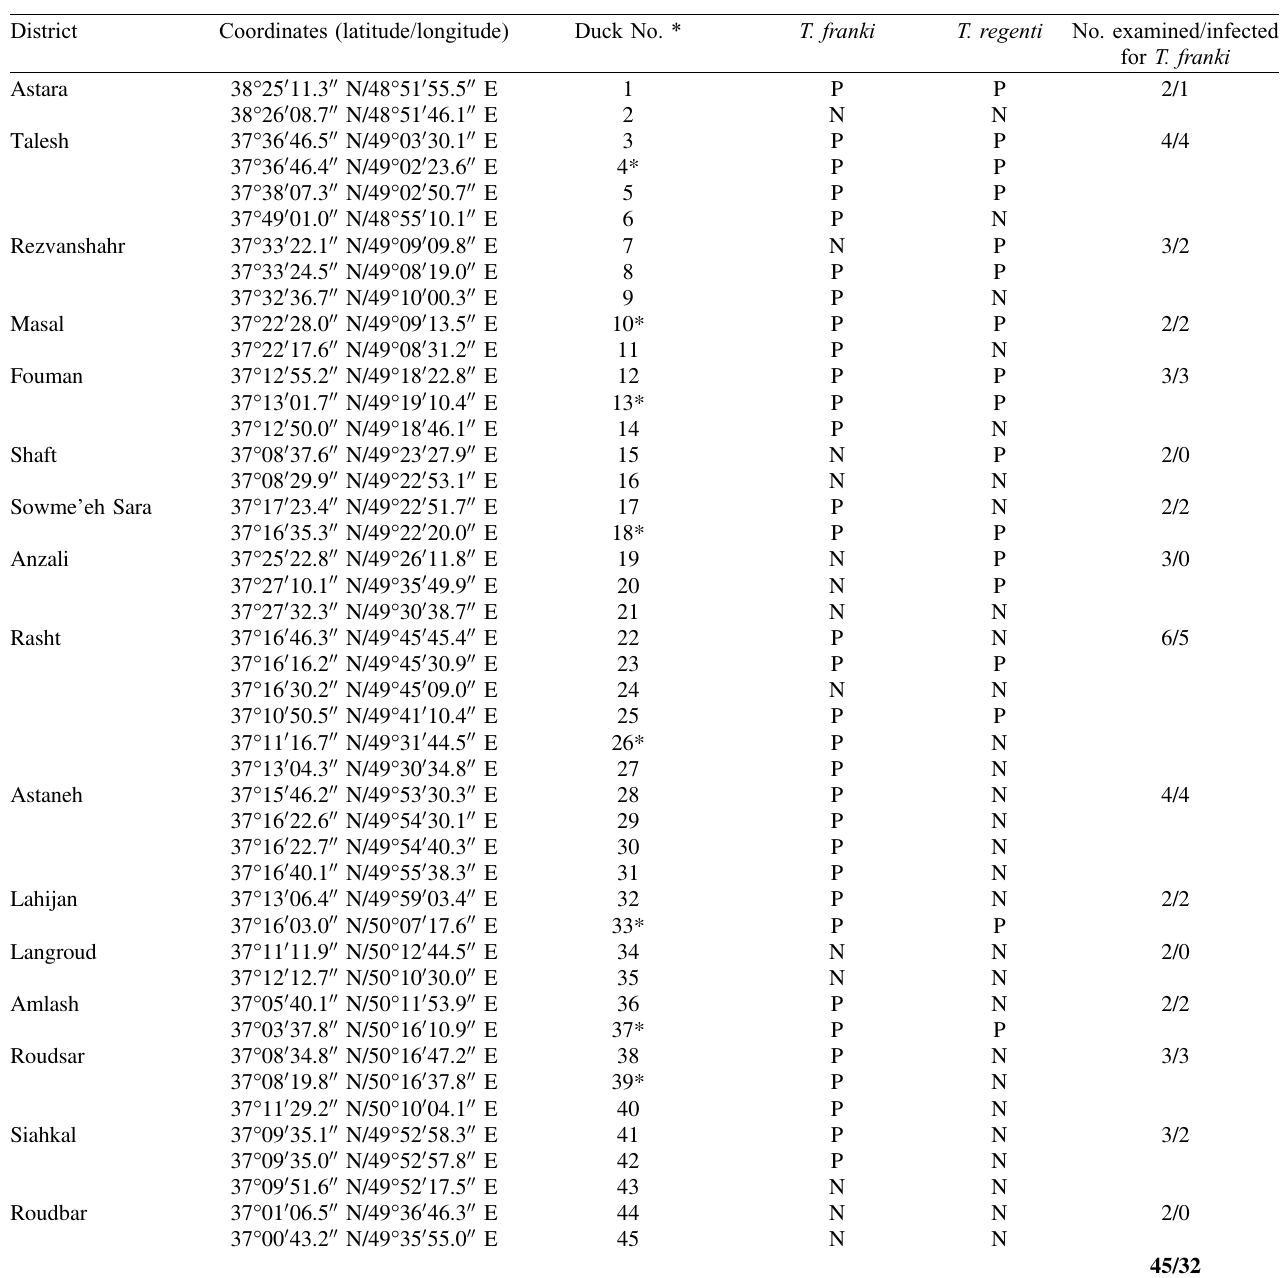
*Numbers with an asterisk show the samples used for molecular studies; P = positive; N =